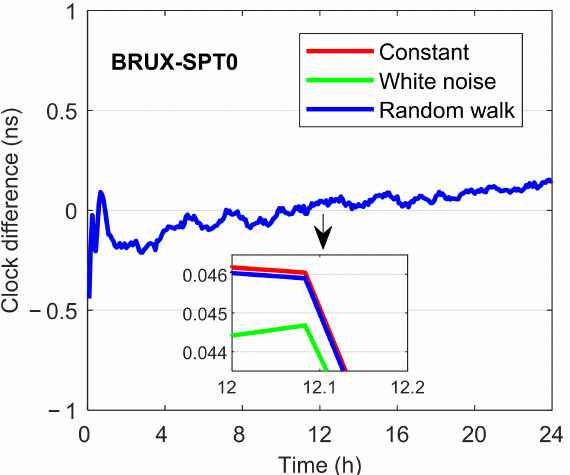
Figure 7. Receiver clock offset estimates with three different IFB dynamic models at BRUX and SPT0 stations on DOY 248, 2021.